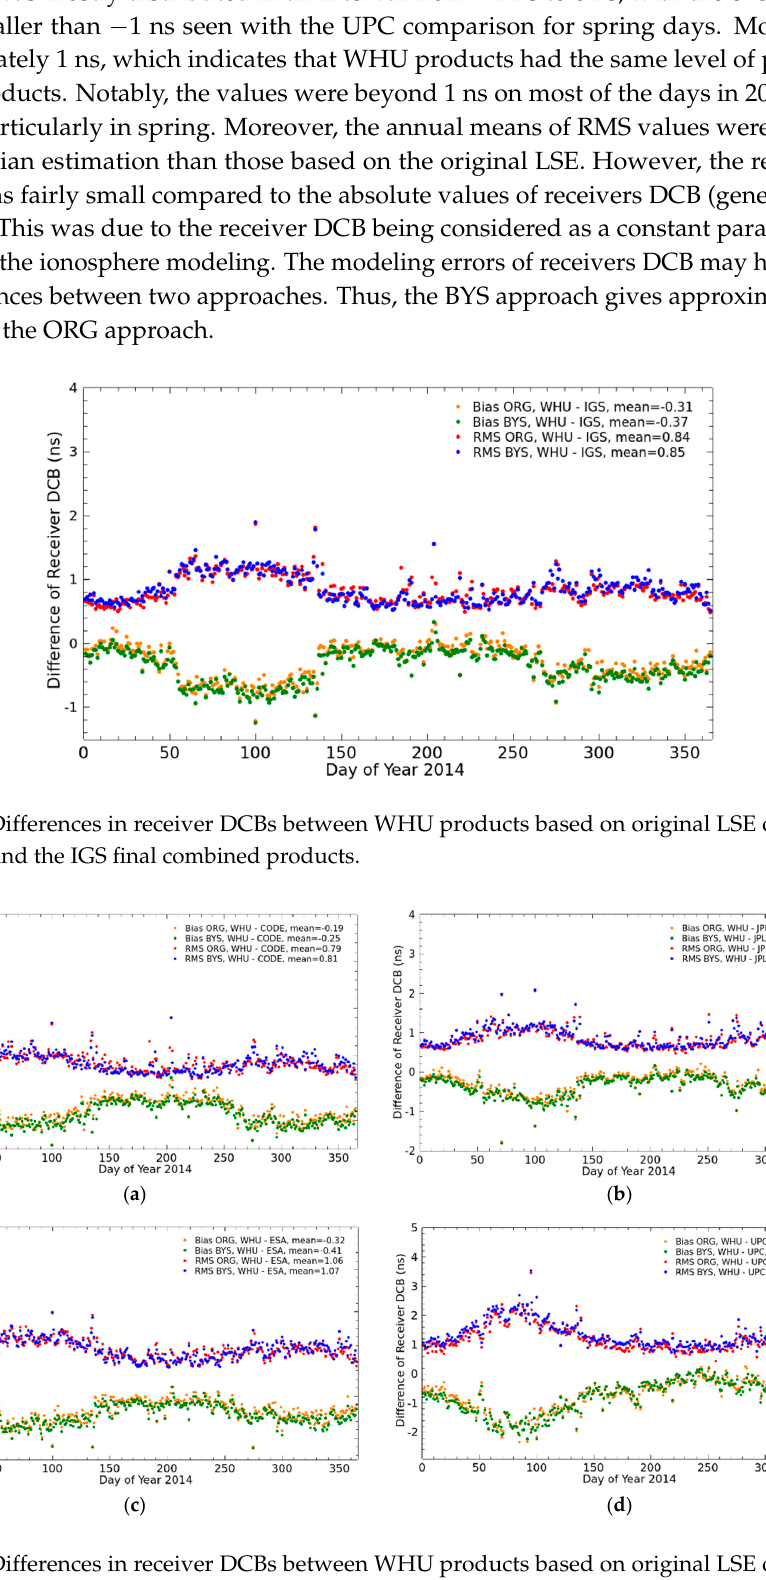
Figure 12. Differences in receiver DCBs between WHU products based on original LSE or Bayesian estimation and IAAC products. ( a ) Compared with CODE. ( b ) Compared with JPL. ( c ) Compared with ESA. ( d ) Compared with